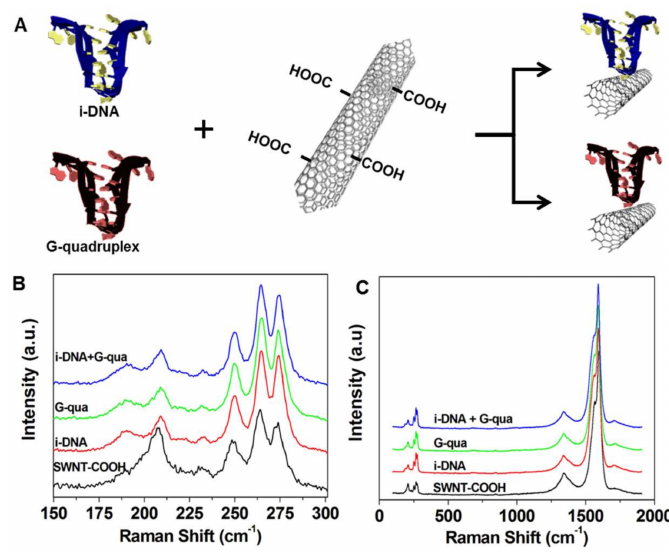
Figure 1. ( A ) Schematic of functionalization of i-motif DNA (i-DNA) and G-quadruplex on f-SWNT; ( B ) Radial breathing mode (RBM) region and ( C ) G and D band Raman spectra of pristine f-SWNT (black), i-DNA/f-SWNT (red), G-quadruplex/f-SWNT (green), and mixture of i-DNA/f-SWNT and G-quadruplex/f-SWNT